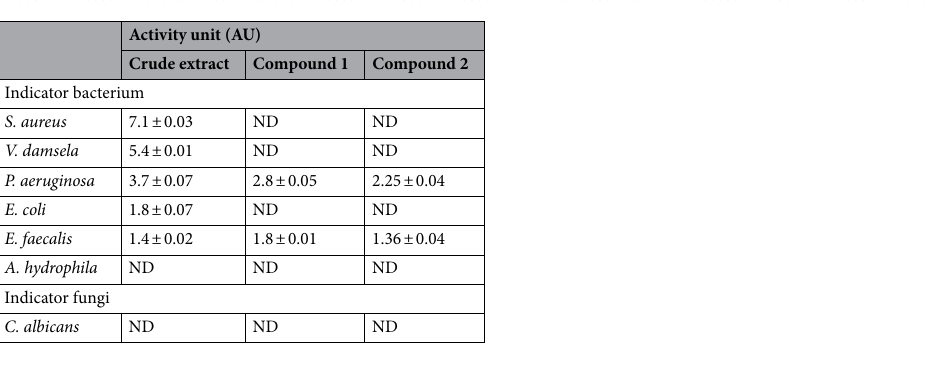
Table 3. Screening the anti-bacterial and anti-fungal activity for the O. dentate crude extract and pure compounds 1 and 2 . ND No data